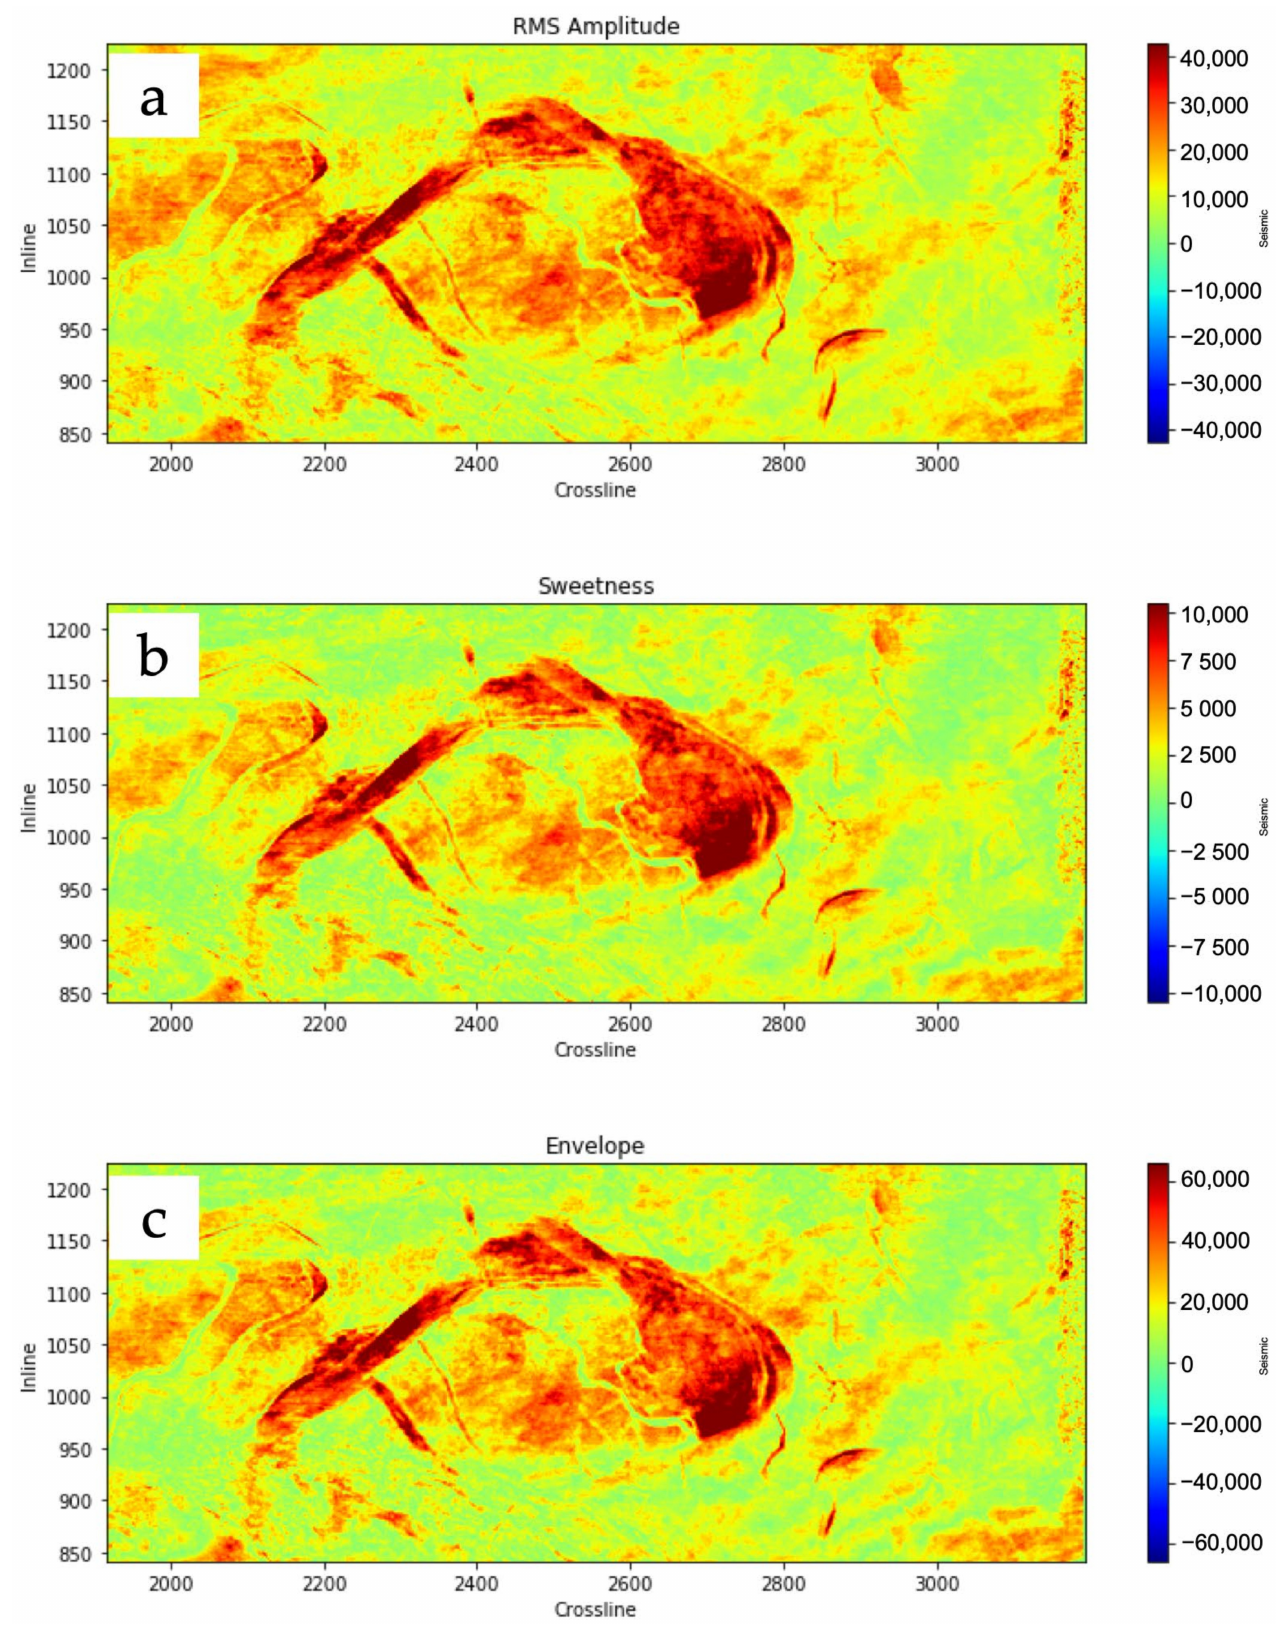
Figure 19. The extracted attributes for channel delineation including ( a ) RMS Amplitude, ( b ) enve- lope, and ( c )